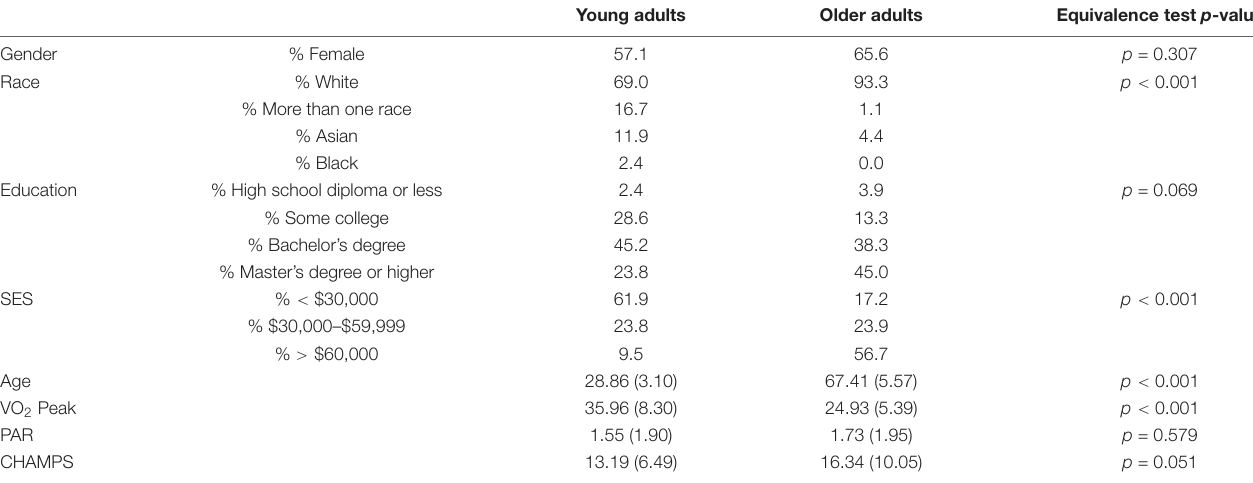
TABLE 2 | Baseline characteristics by age group; SES, socioeconomic status; PAR, days of moderate to vigorous physical activity on the Stanford 7-Day Physical Activity Recall; CHAMPS, Community Health Activities Model Program for